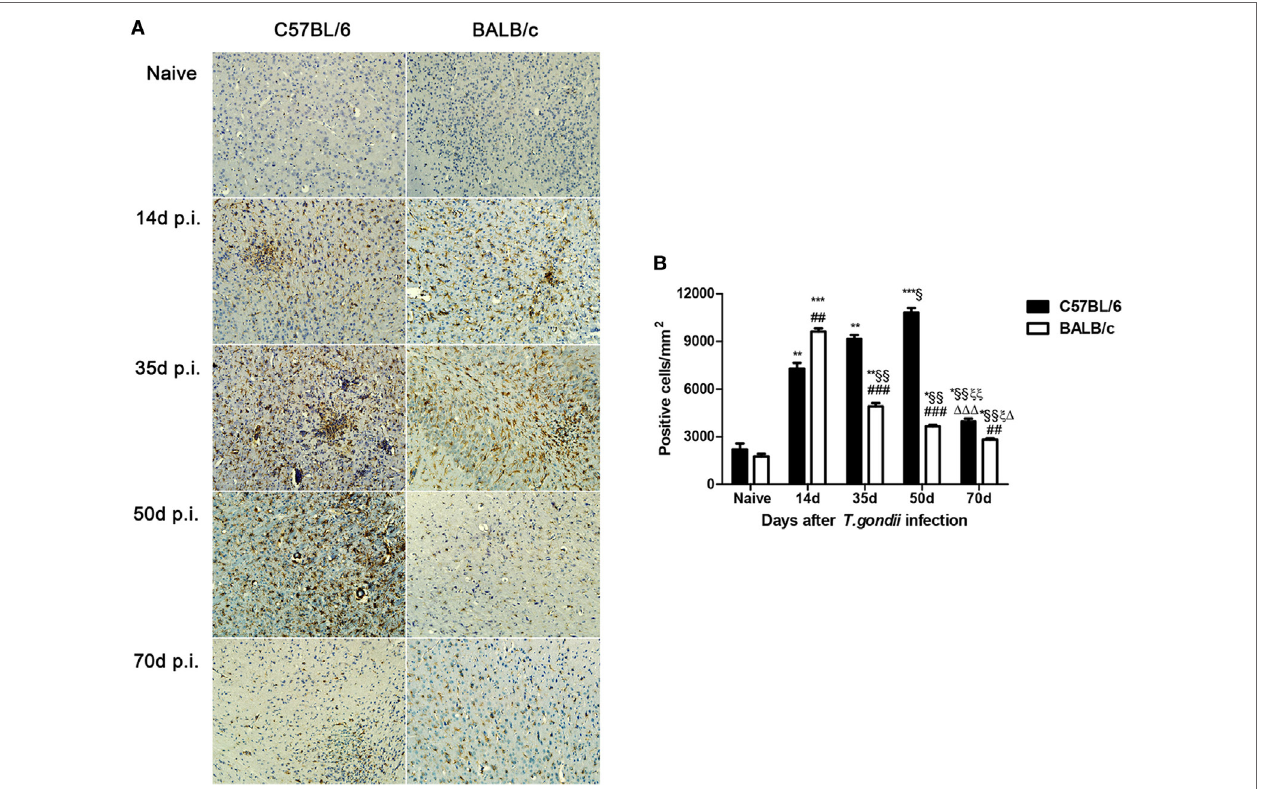
FigUre 2 | Expression of activated microglial marker Iba1 in the brains of Toxoplasma gondii Pru strain-infected C57BL/6 and BALB/c mice. (a) Immunohistochemistry for Iba1 in the brains of uninfected mice, and mice infected with T. gondii Pru strain at days 14, 35, 50, and 70 post infection (p.i.). Original magnification 200 × . (B) Quantitative analysis of Iba1-positive microglia. The density of positive cells was expressed as the number of cells per square millimeter. Data are presented as means ± SD; experiments were performed with three mice per group. * P < 0.05, ** P < 0.01, and *** P < 0.001 vs Naive; § P < 0.05 and §§ P < 0.01 vs 14 days p.i.; ξ P < 0.05 and ξξ P < 0.01 vs 35 days p.i.; Δ P < 0.05 and ΔΔΔ P < 0.001 vs 50 days p.i.; ## P < 0.01 and ### P < 0.001 vs C57BL/6